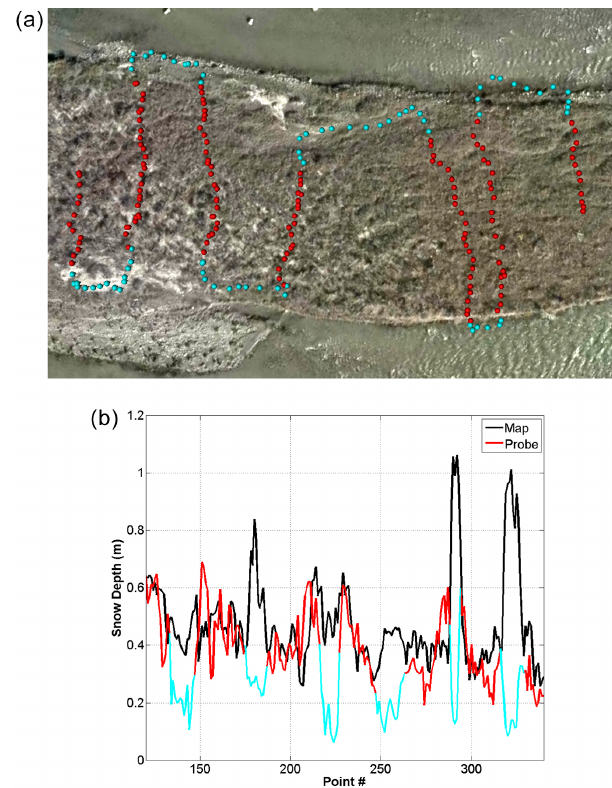
Figure 7. (a) Snow depth measurements made across one of the is- lands in the Hulahula River (see island inset in Fig. 1) reveal that the primary offsets between probe and map depths (b) were caused by changes other than snow depth itself. Superposition of probe loca- tions on the summer orthoimage (a) clearly show that the largest offsets occurred where the probes extended into the active river channel (blue dots). In some locations at the edge of the island, the probe points were not over open water, but riverine erosion, along with snow-compressed shrubs, produced large (0.2 to 1.0m) offsets that are accurate but not related to snow depth. Note: the colors of the probe points in (a) match those used for the lines in (b)